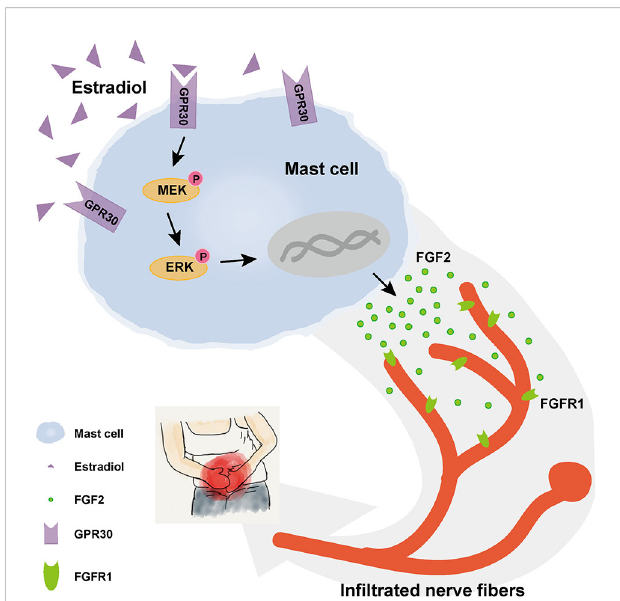
FIGURE 8 Schematic diagram of the present fi ndings. High concentration of estrogen in local endometriotic environment could promote the secretion of FGF2 through GPR30 via MEK/ERK pathway in mast cells. Enhanced level of FGF2 by mast cells in ovarian endometriotic lesion may aggravated endometriosis-related